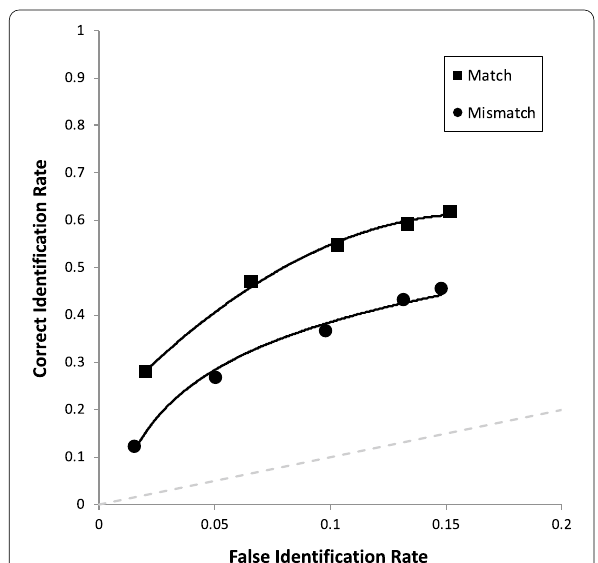
Fig. 3 ROC curve for match (Full-Full and Internal-Internal) versus mismatch conditions (Full-Internal and Internal-Full), collapsed over all other manipulations